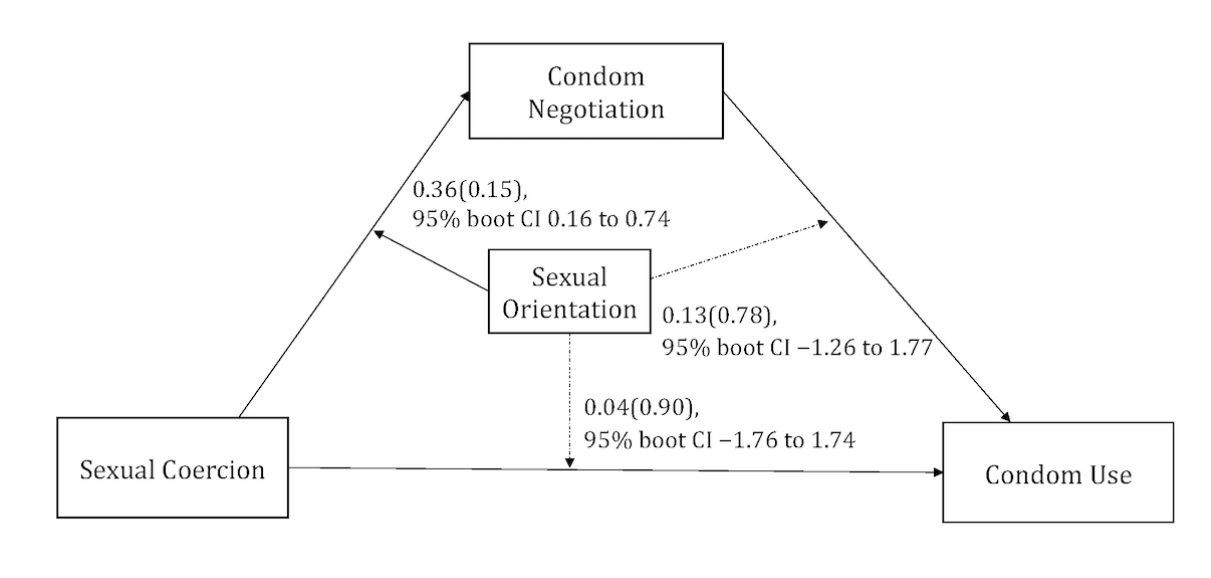
Figure 2. Tested moderated mediation model.